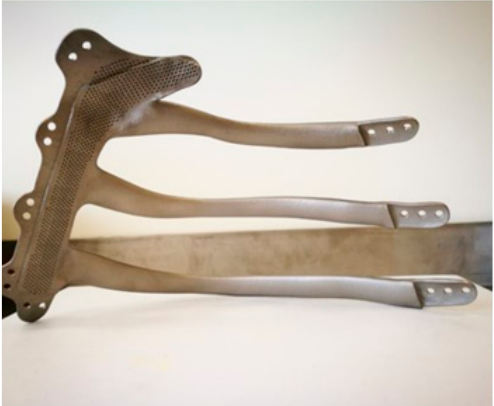
Figure 12. Three-dimensional printed titanium alloy chest implants. Reprinted with